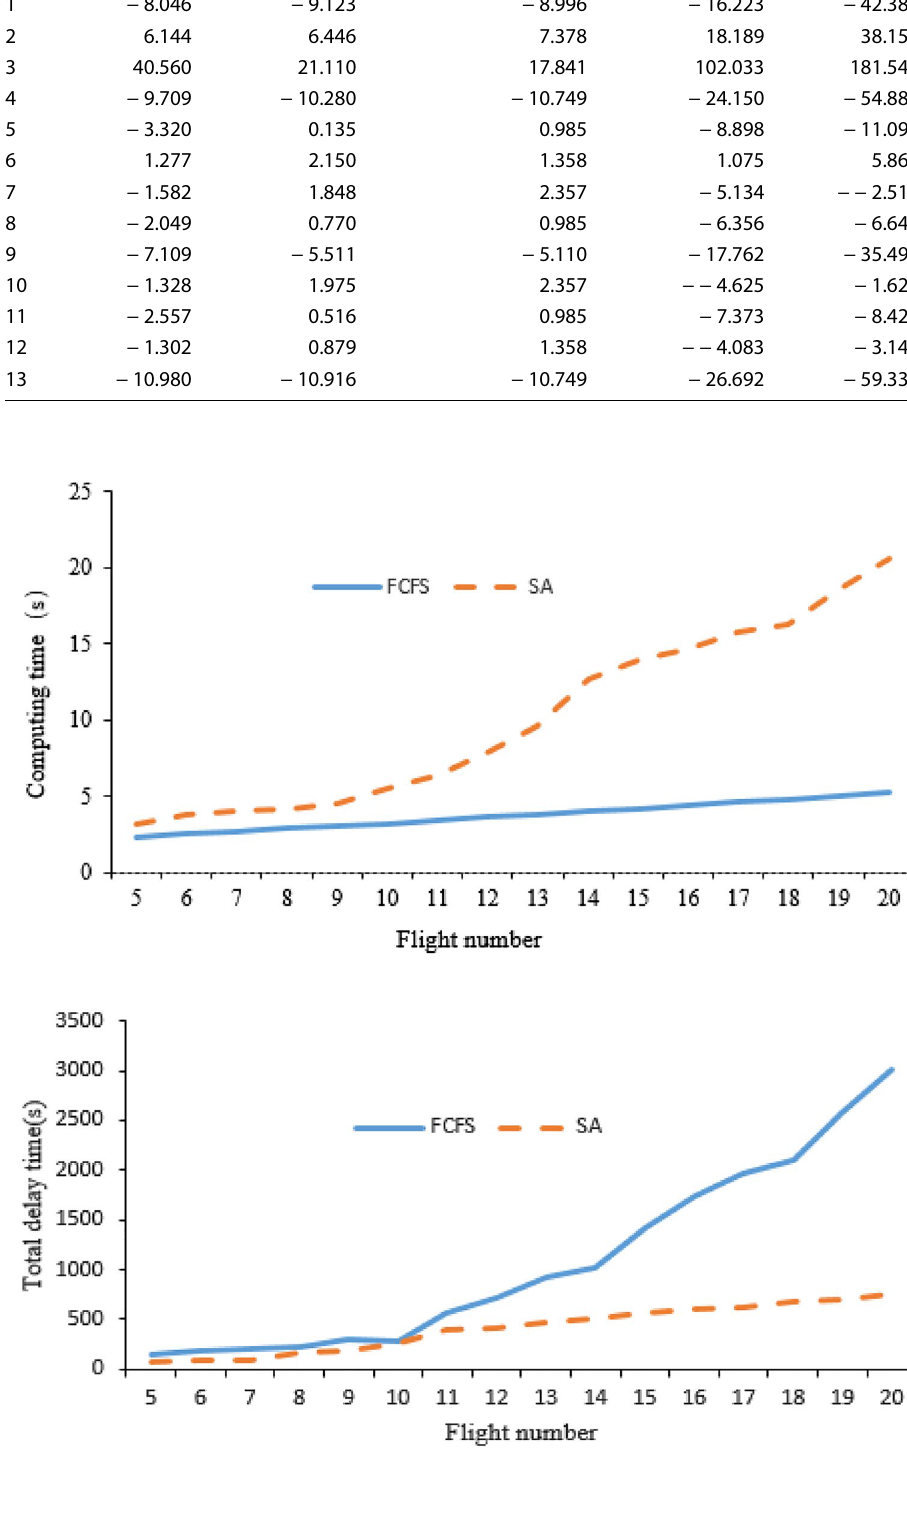
Table 8 Comprehensive scores of different stakeholders